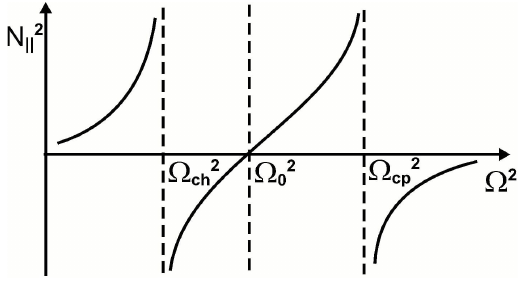
Fig. 3. The longitudinal refraction index as a function of wave fre-